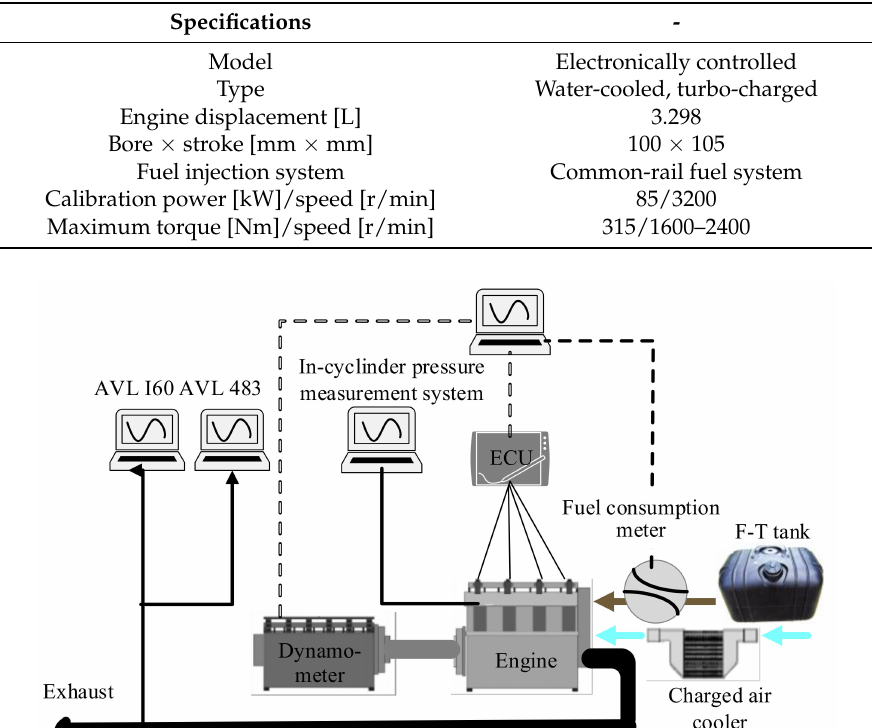
Table 1. Specifications of the test engine.